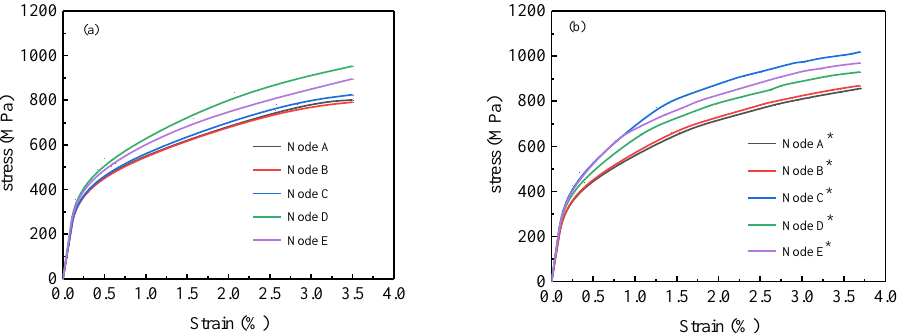
Figure 14. Stress–strain curves at the special points in numerical simulation: ( a ) 1# region, ( b ) 2# region.